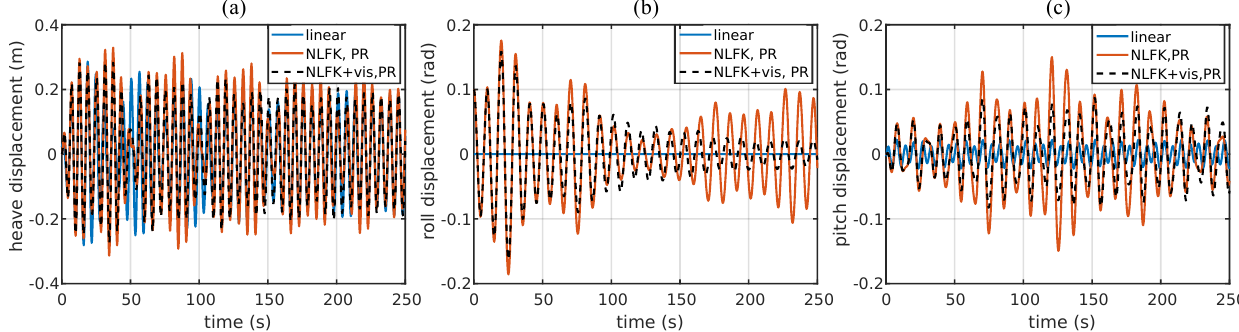
Fig. 7. Viscous effect on the parametric resonance in roll and heave, illustrated by the heave, roll and pitch displacements in (a), (b) and (c), respectively. In this figure, the PTO force is not